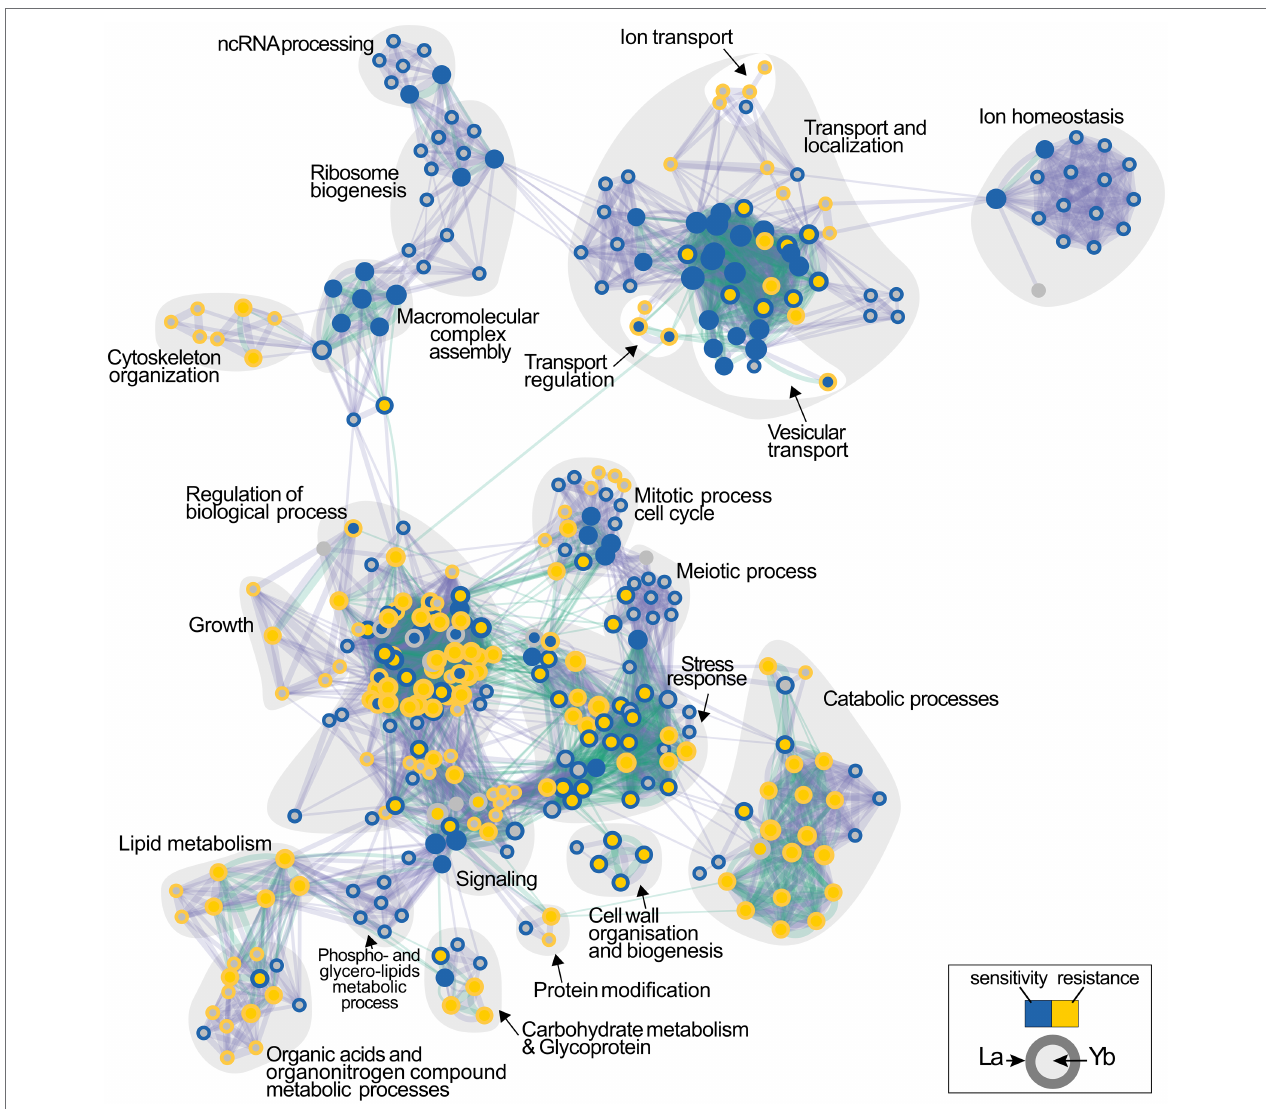
FIGURE 3 | Functional enrichment analysis network of functions involved in the cellular response to lanthanides. Functions whose deletion renders cells either sensitive or resistant to La (outer circle) or Yb (inner circle) are shown in blue and yellow, respectively. Interlines represent gene overlap between two related functions, and edge width is proportional to the number of shared genes. The enrichment map was built using GSEA and visualized by the Enrichment map plug-in in